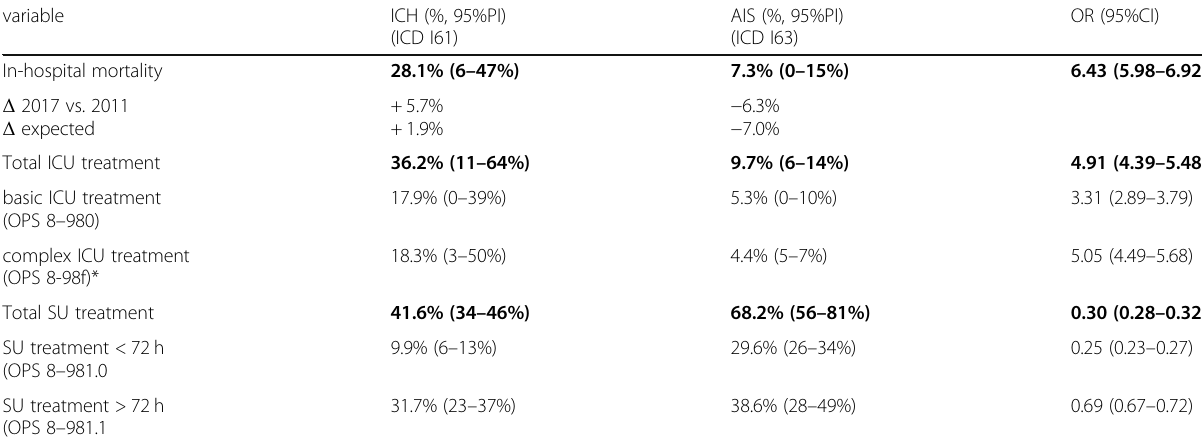
Table 2 Treatment characteristics comparing patients treated in German hospitals for intracerebral hemorrhage (I61) and acute ischemic stroke (I63) between 2011 and 2017 ( n = 1.721.447)